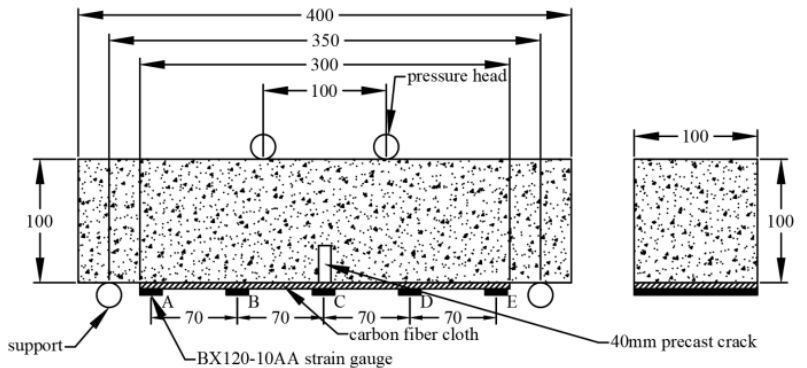
Figure 6. Flexural testing set up.